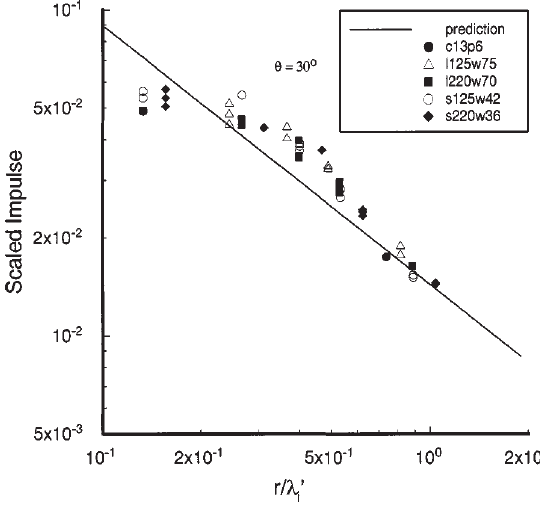
Fig. 8. Scaled impulse versus r/λ (cid:48) i for θ = 30 ◦ with least squares